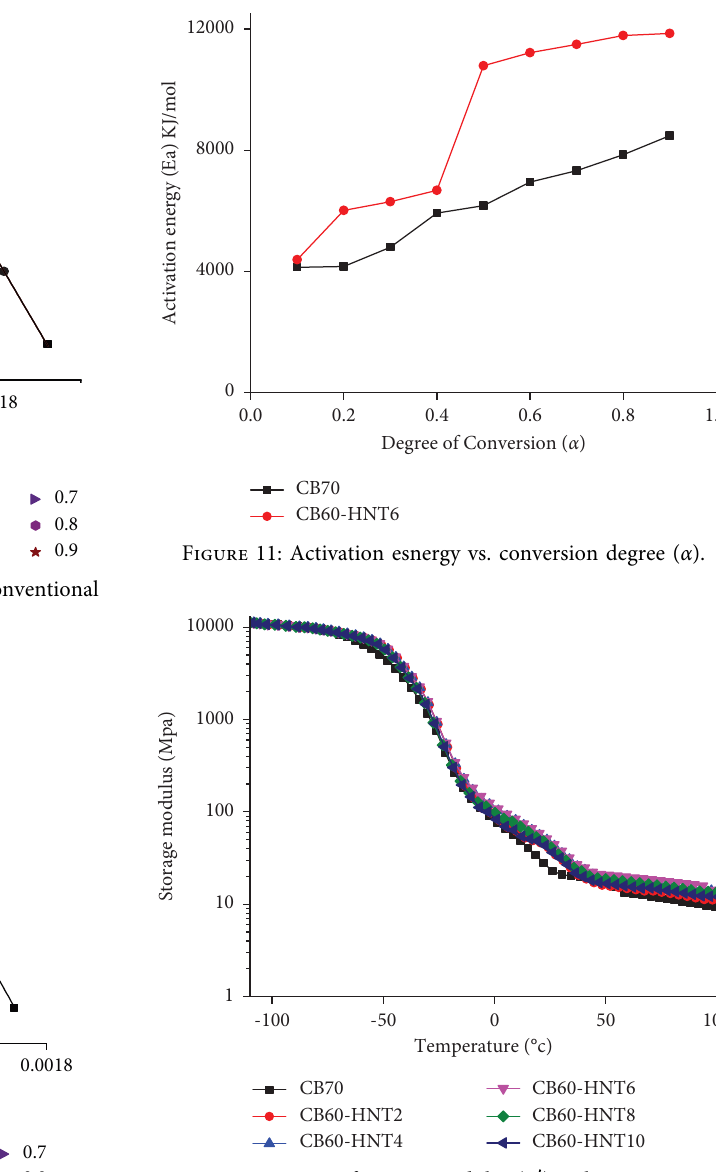
Figure 12: Variation of storage modulus ( E ′ ) with temperature for ACM composites. 5: Dynamic mechanical properties of ACM